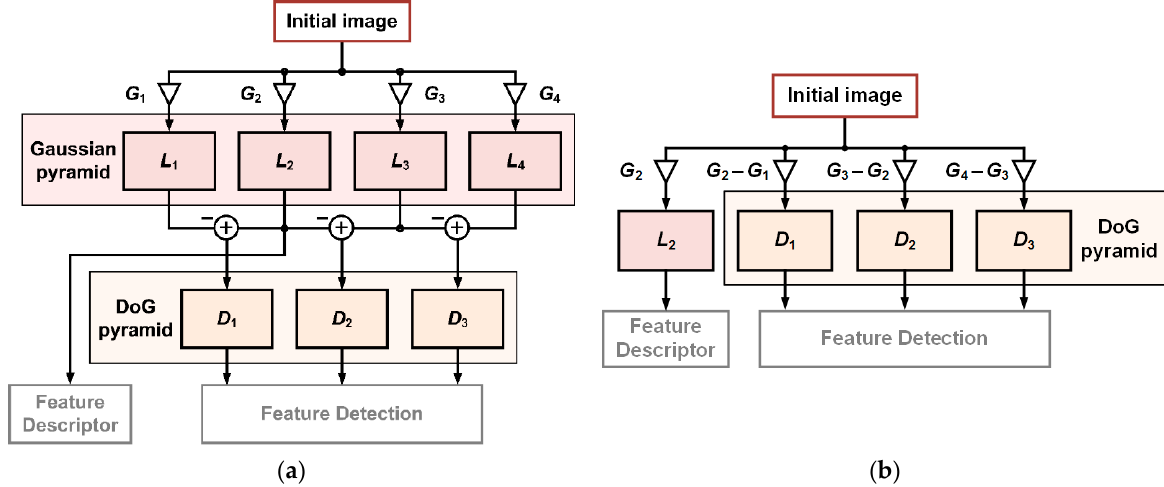
Figure 2. ( a ) Conventional structure and ( b ) the proposed structure in realizing image pyramids.